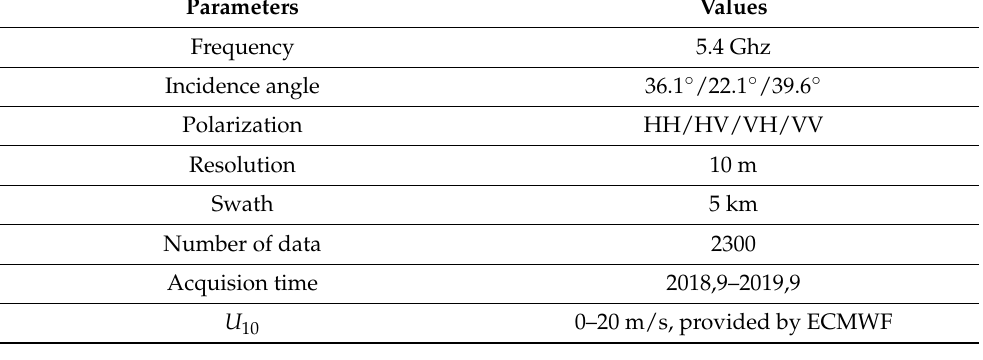
Table 1. Parameters of used datasets in this study.